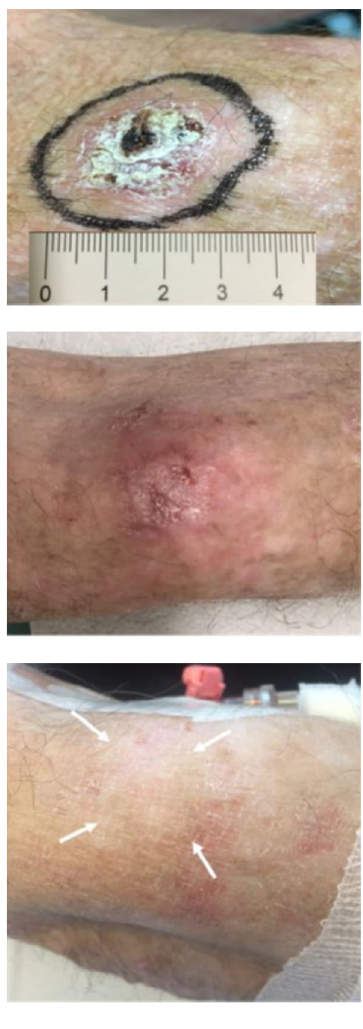
Figure 1. Effects of 167 GY/s (15-Gy in 90-ms) electron beam treatment of a 3.5-cm skin tumor in the first FLASH-RT of a human subject. Top: Day 0, middle: Day 21, bottom: ~ Day 150 16 (reprinted with